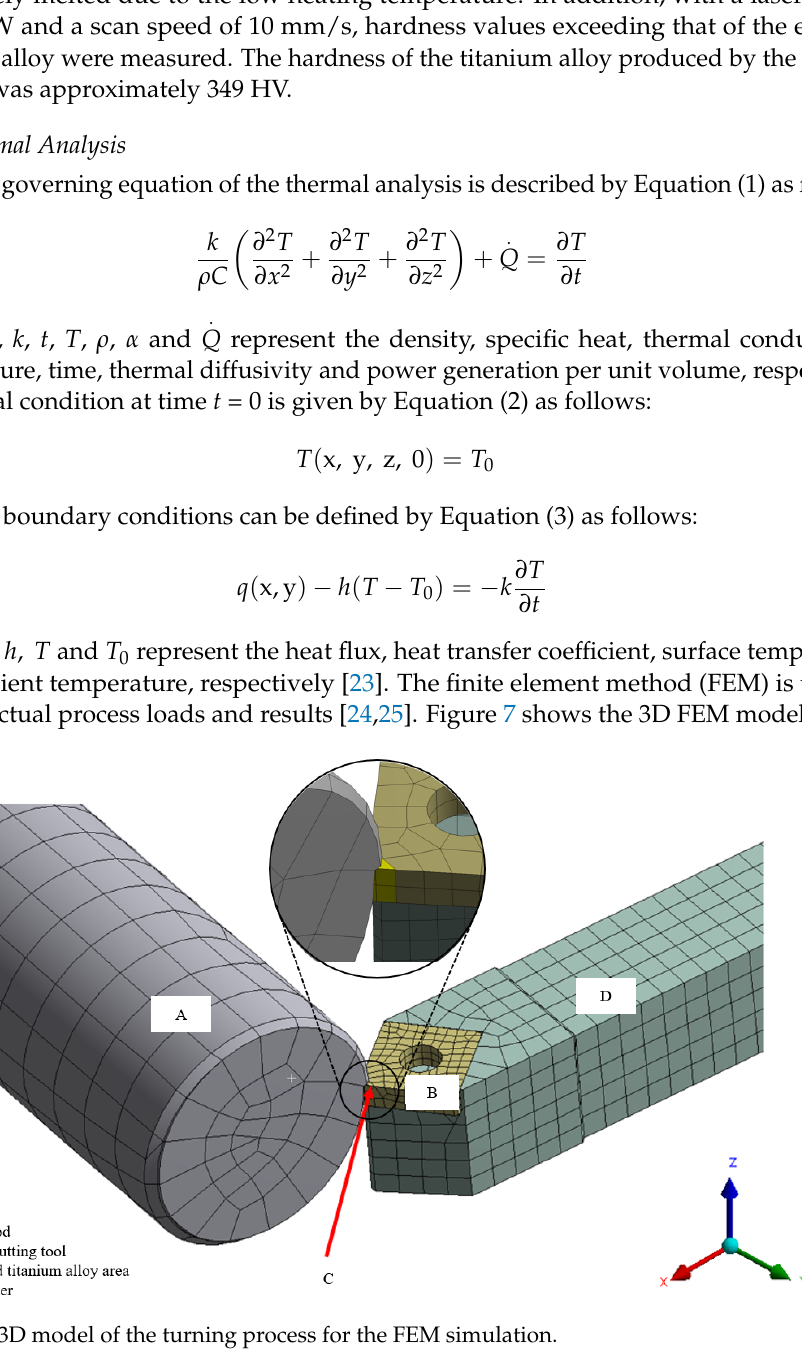
Figure 7. 3D model of the turning process for the FEM simulation .